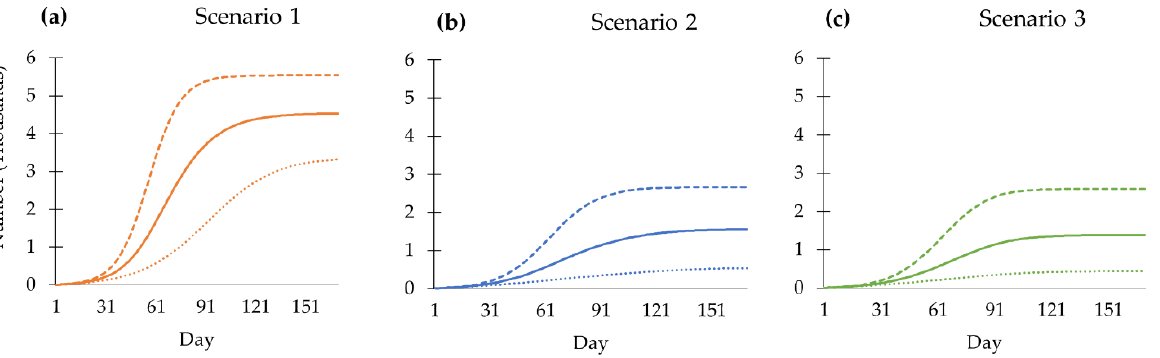
Table 4. ICER of grand cost per case averted and death averted by day 170.